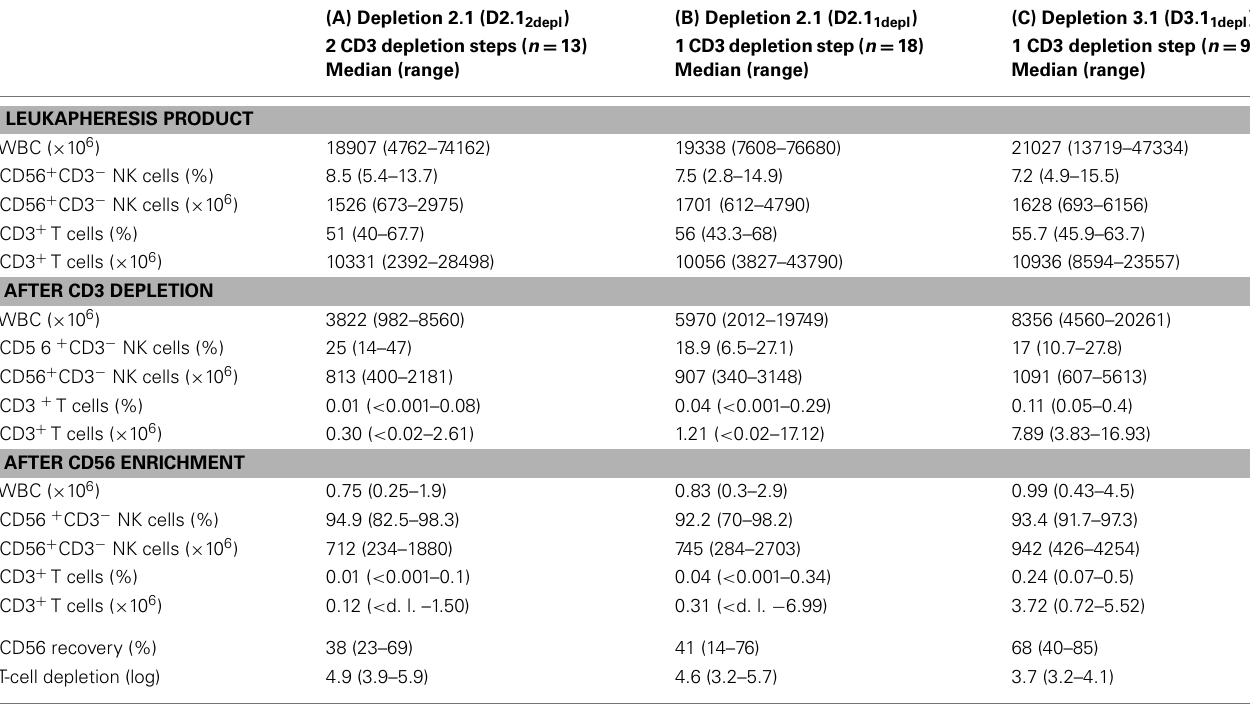
Table 1 | Percentage and absolute count of NK andT cells using different GMP-grade enrichment procedures for NK cell